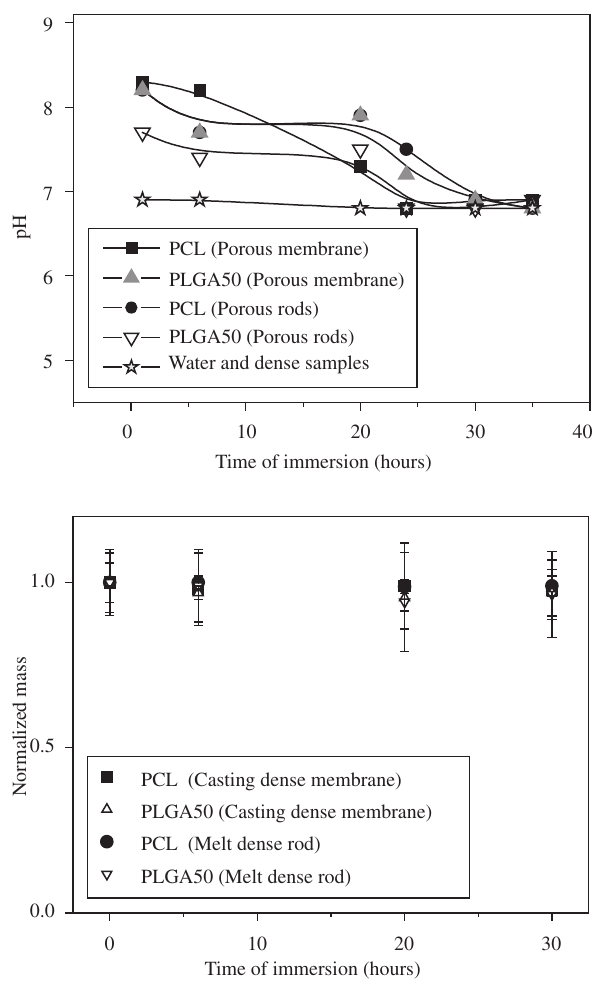
Figure 1. Normalized mass and pH variation of PCL and PLGA50 samples in distilled